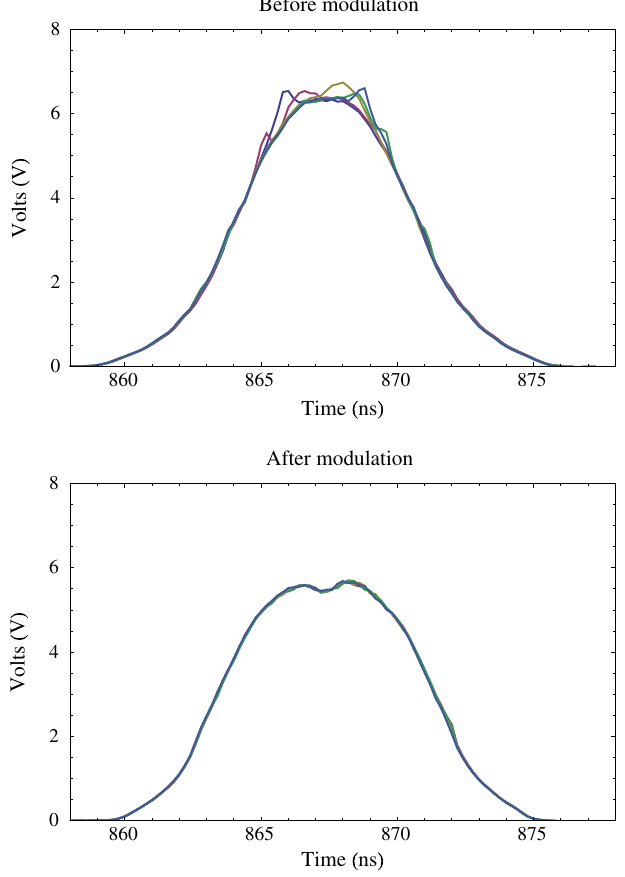
FIG. 6. These are snapshots taken by the SBD before and after modulation at 150 GeV. Before any modulation, the bunch is dancing. The result after modulating the beam for 14 s is the creation of a divot structure in the bunch and stoppage of the tip